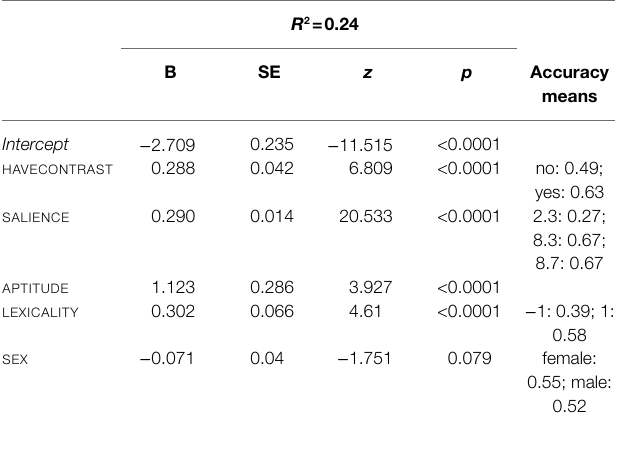
TABLE 5 | Results of a multiple logistic regression analysis with tone complexity as the tonality variable.